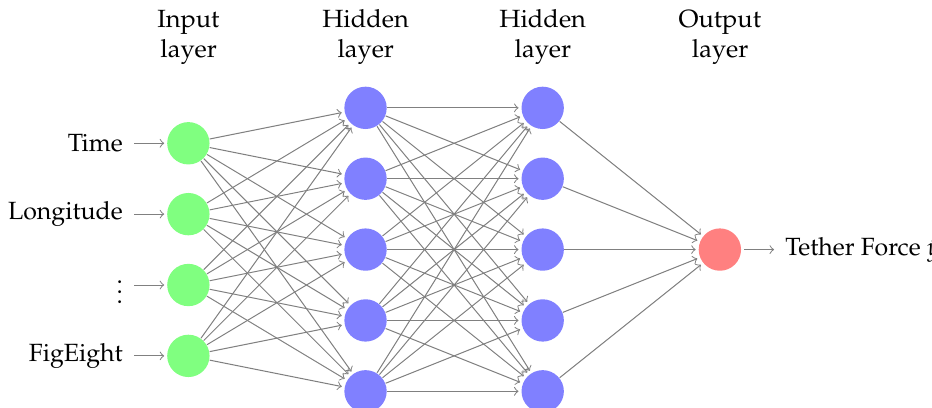
Figure 21. A neural network illustration of tether force prediction with two hidden layers.